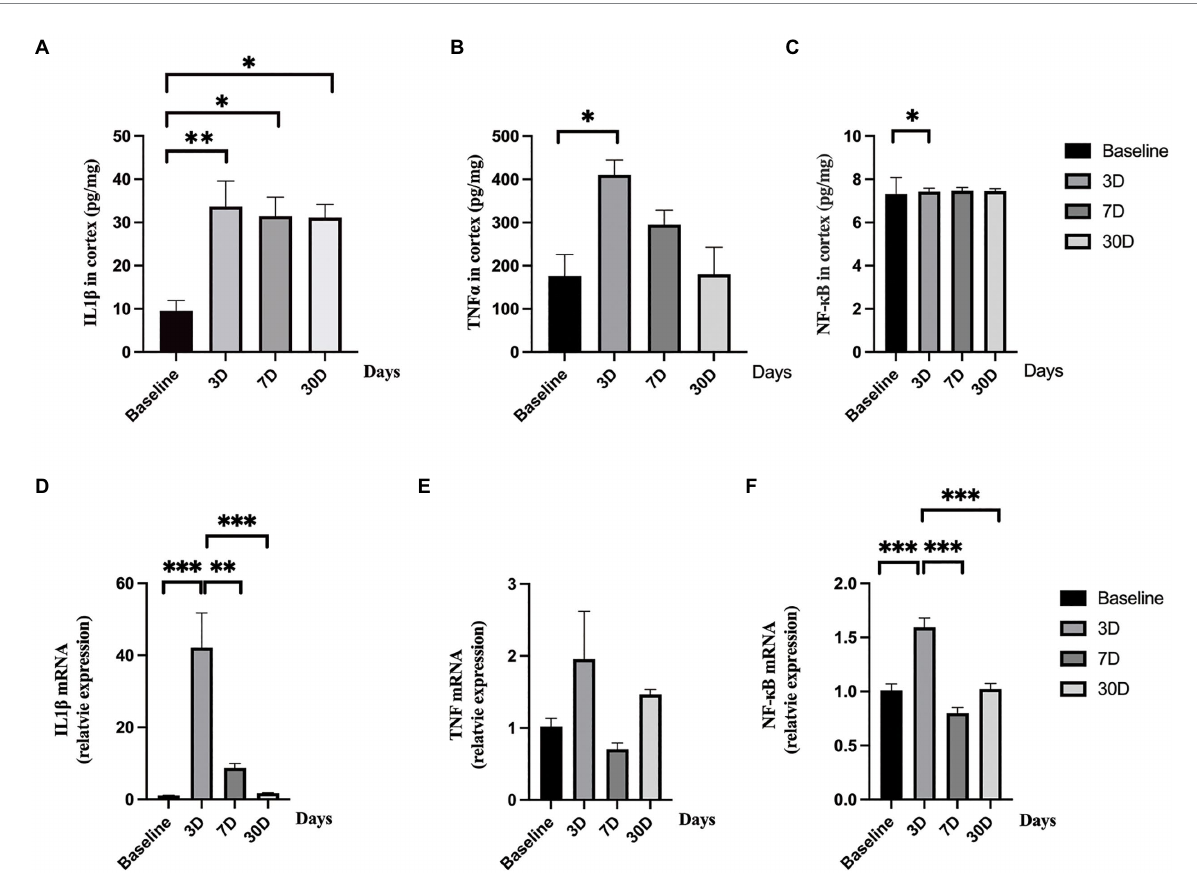
FIGURE 4 Central nerve system inflammatory responses. (A–C) The levels of IL-1 β , TNF α , and NF- κ B significantly elevated after lipopolysaccharide (LPS) exposure as compared with rats treated with normal saline (NS). (D–F) The mRNA levels of IL-1 β and NF- κ B significantly increased after lipopolysaccharide (LPS) exposure while the level of TNF α did not change as compared with rats treated with normal saline (NS). Data were presented as mean ± SEM. * p < 0.05, ** p < 0.01, *** p < 0.001 vs. control